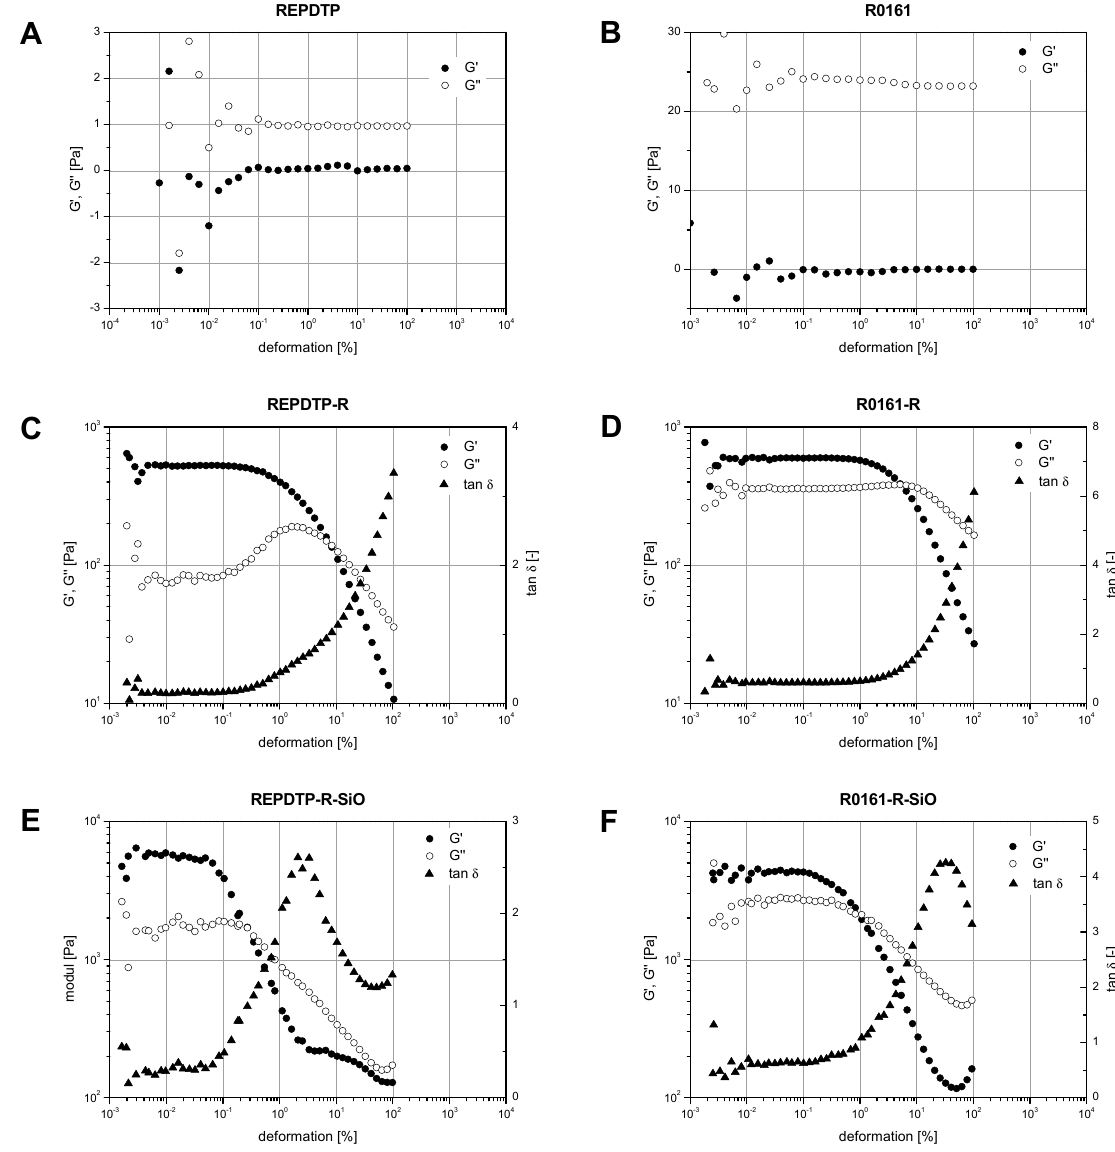
Figure 7 : Strain sweep tests under oscillatory shear at 6 rad/s; material category I ( A – D ) and material category III ( E , F ). category III ( E , F